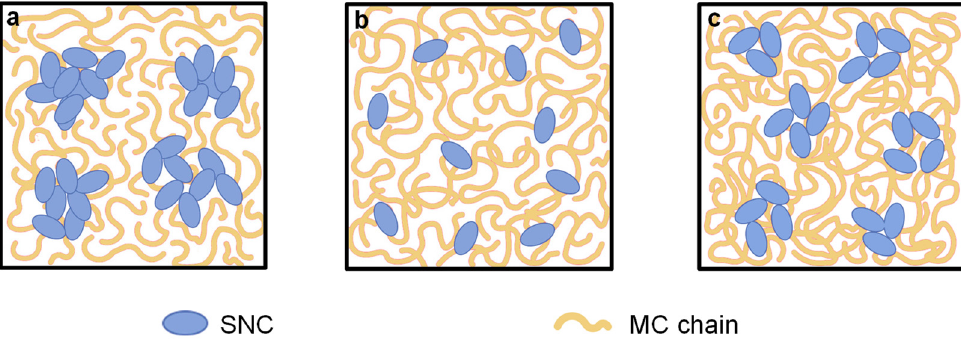
Figure 3. A schematic illustrating the distribution of SNC in MC matrix: ( a ) M20-15% SNC; ( b ) A4C- 15% SNC; ( c ) A4M-15% SNC. 15% SNC; ( c ) A4M-15%